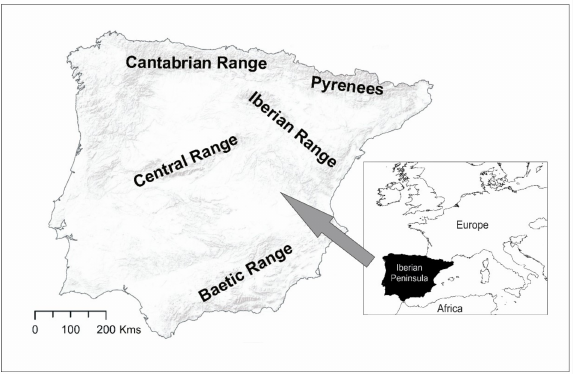
Figure 1. Iberian Peninsula with the main mountain ranges and the location on the European